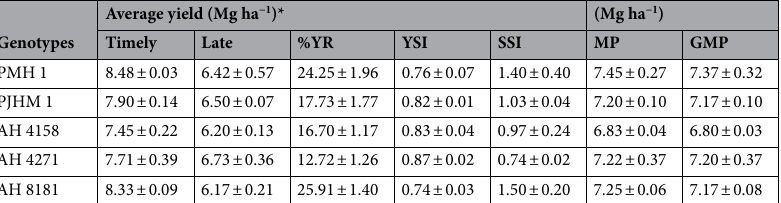
Table 6. Stover stress tolerance indices of maize genotypes under timely and late sown conditions. *Mean yield of 2 years; %YR: Percentage yield reduction, YSI: Yield stability index, SSI: Stress susceptibility index, MP: Mean productivity, GMP: Geometric mean